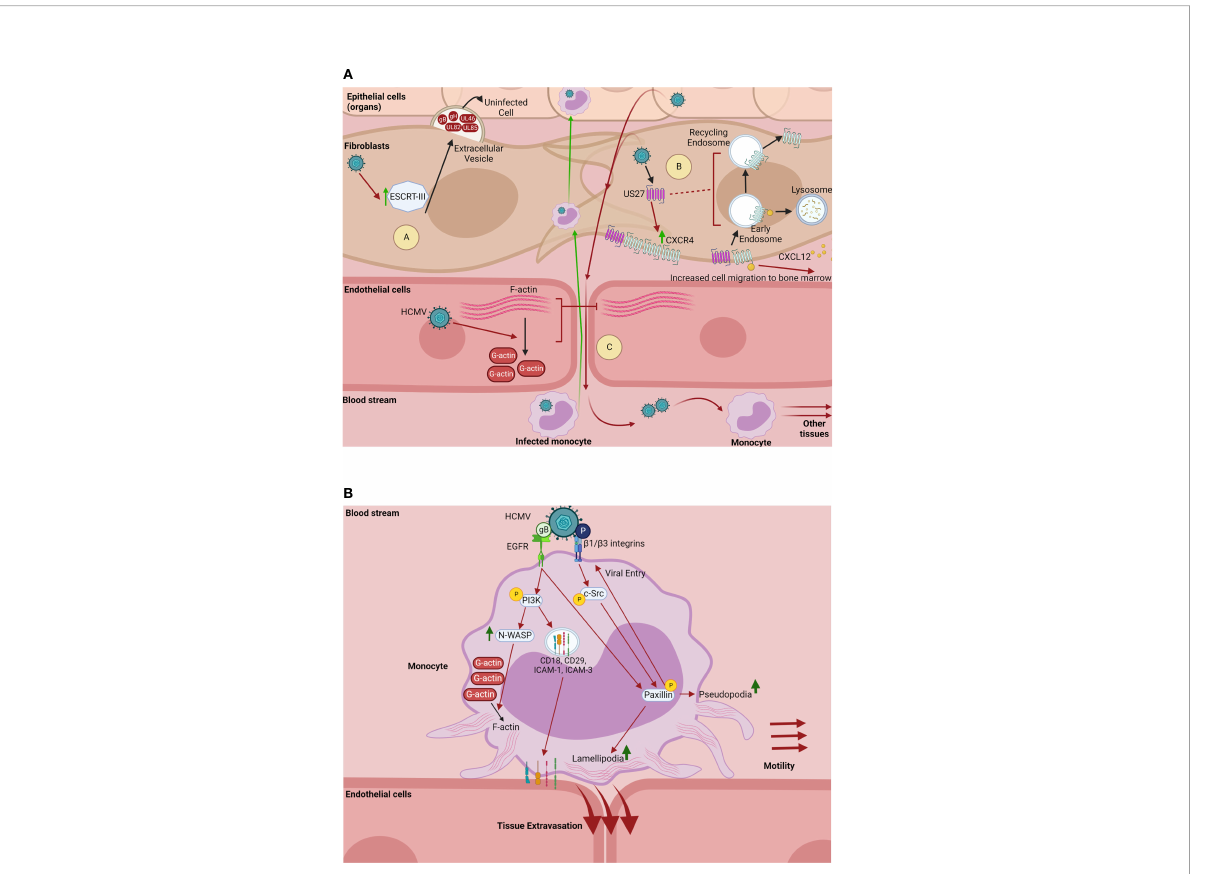
FIGURE 3 HCMV manipulates intracellular traf fi cking components to promote cell migration and viral spread. (A) HCMV dysregulates traf fi cking components to promote viral spread. (A) In fi broblasts, HCMV upregulates ESCRT-III, a component of the ESCRT complex and mechanism for extracellular vesicle biogenesis (77). HCMV-induced upregulation of ESCRT-III correlates with an increase in extracellular vesicle generation and release into the extracellular space. Extracellular vesicles generated through HCMV infection contain the late proteins gB, gH, UL46, UL82, and UL85. These vesicles enhance viral spread and the ef fi ciency of infection, potentially by priming uninfected cells for a proviral environment (77). (B) HCMV-encoded US27 increases the amount of the chemokine receptor CXCR4 in fi broblasts, co-localizes with CXCR4 at the cell surface, and is likely endocytosed along with CXCR4 after ligand (CXCL12)-binding (76, 78). US27 also enhances the rapid internalization of CXCR4 after CXCL12 stimulation and signi fi cantly slows the receptor recycling back to the plasma membrane, causing a potentiation of CXCR4 chemotactic signaling. The US27-mediated potentiation of CXCR4 signaling greatly increases the chemotaxis of infected cells towards the ligand CXCL12, which is expressed in the bone marrow that serves as the HCMV latency compartment (9, 73, 76, 78). (C) HCMV infection of endothelial cells causes the depolymerization of actin which results in the loss of F-actin stress fi bers that maintain the integrity of cellular junctions between endothelial cells (75). The breakdown of actin stress fi bers increases the permeability of the endothelial cell layers, allowing HCMV-infected peripheral blood monocytes through to carry HCMV into the fi broblasts and epithelial cells of organs. Conversely, HCMV-induced endothelial layer permeability allows for newly produced virus to be released into the bloodstream, where circulating monocytes can then be infected, facilitating viral dissemination to other tissues (75). Made with BioRender.com. (B) HCMV enhances monocyte motility and tissue extravasation. On monocytes, HCMV binds and activates EGFR and b 1/ b 3 integrins via its glycoproteins gB and pentamer complex (P), respectively (79). This receptor-ligand engagement activates the PI3K and c-Src signaling cascades, which in turn chronically activates the downstream cytoskeletal and focal adhesion regulator paxillin (80). Activation of PI3K by gB also upregulates the highly active actin nucleator N-WASP, which signi fi cantly upregulates the formation of F-actin (81). Further, HCMV activation of PI3K redistributes intracellular stores of adhesion molecules (CD18, CD29, ICAM-1, and ICAM-3) to the cell surface (82). Together, the HCMV-induced upregulation of N-WASP and paxillin, as well as increased transport of adhesion receptors, signi fi cantly increase the formation of monocyte lamellipodia and pseudopodia, creating a “ hyper ” adhesive and motile monocyte, which enhances monocyte motility and tissue extravasation (9, 80 – 82). Further, activation of paxillin is required for ef fi cient viral entry into monocytes (80). Made with